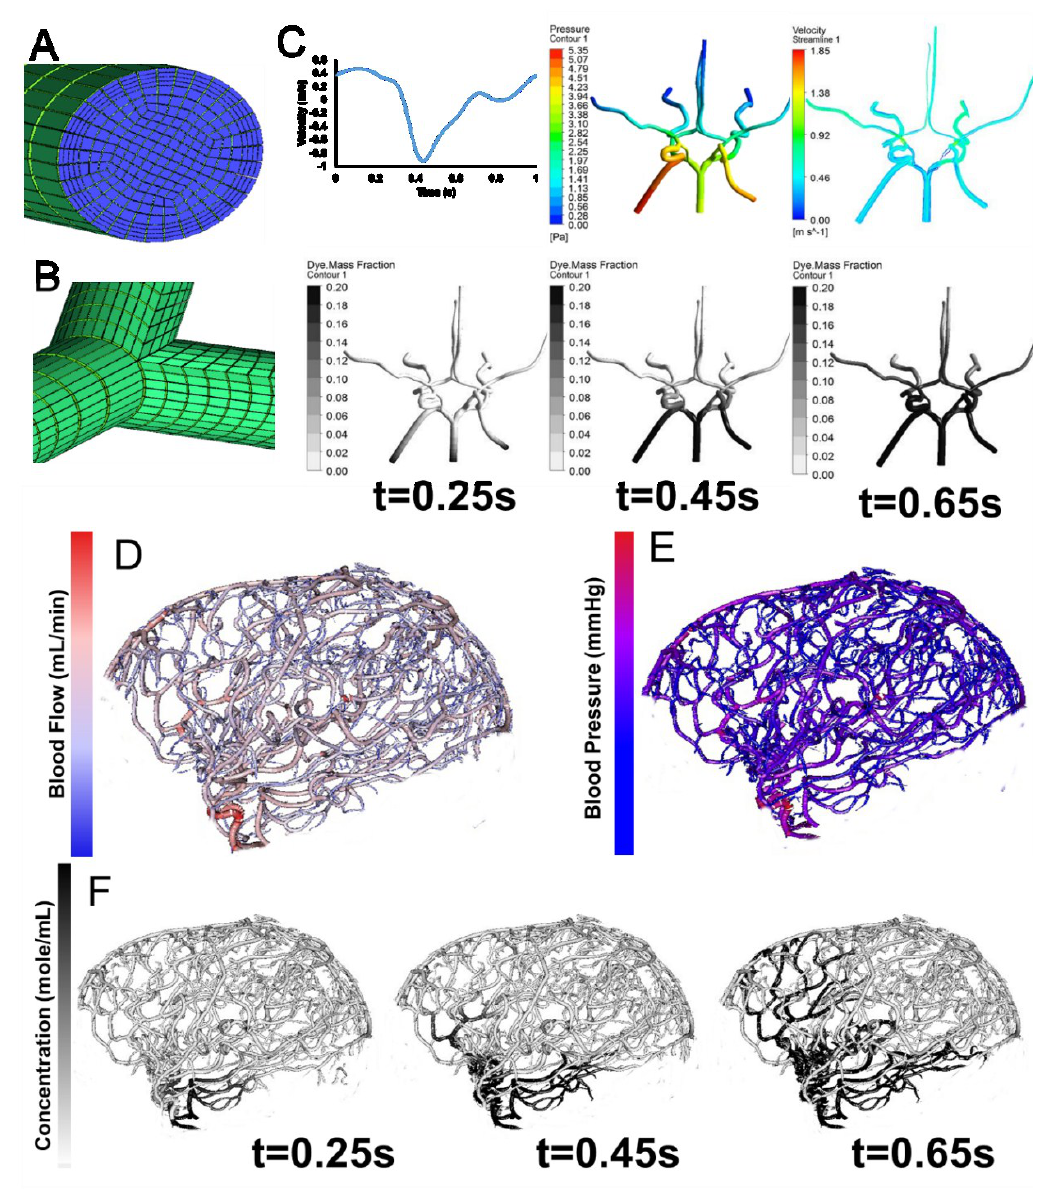
Figure 6. Parametric meshing of the cerebral vasculature for 3D hemodynamic simulations. ( A ) Cross section of the parametric meshing of the segmented cerebral vasculature; ( B ) Parametric mesh at the bifurcations; ( C ) 3D hemodynamic simulation of the cerebral vasculature with pulsatile boundary conditions showing velocity fields, pressure fields, and dye convection at three time frames, 0.25 s, 0.45 s, 0.65 s; ( D ) Volumetric blood flow rate for each individual segment; ( E ) Blood pressure estimation for the entire tree; ( F ) Dynamic contrast agent distribution for three time frames 0.25 s, 0.45 s, 0.65 s after injection of a contrast agent. Inlet boundary conditions are provided in C for velocity and outlet boundary conditions are static